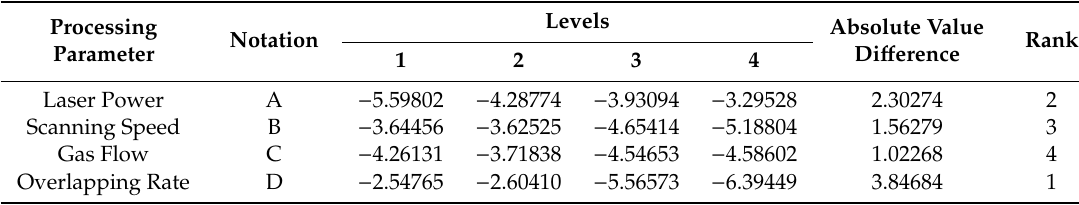
Table 9. Mean of S / N (GRG) for each processing